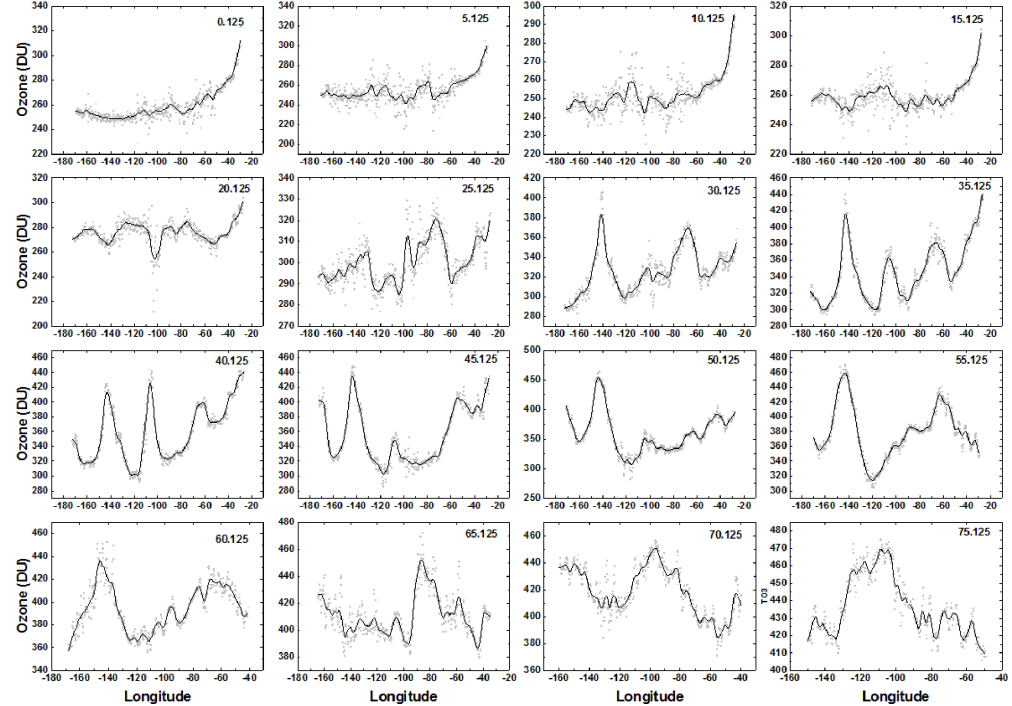
Figure 16. Northern Hemisphere: solid lines are approximately 30min averages in solar time at 18:38 UTC on 17 April 2016 for ozone variation between 0 and 75 ◦ N latitude in 0.25 ◦ latitude bands for 17 April 2016 at 17:36